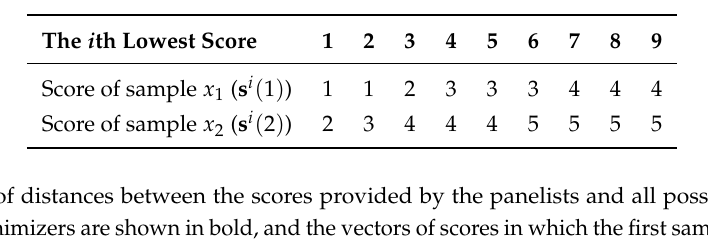
Table 1. The scores assigned by the panelists in Example 1.